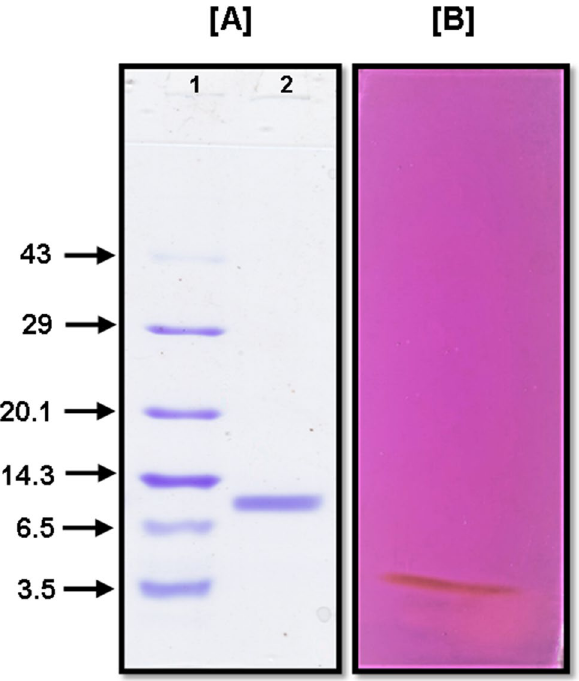
Figure 1. ( A ) SDS-PAGE profile (15%), analyses of purified SSTI from, S. surattense seeds, stained with Coomassie Brilliant Blue. (1) Standard protein markers, (2) purified fraction after cation exchange resin; ( B ) PAS staining of purified SSTI, indicating its glycoprotein nature (12% SDS-PAGE). Uncropped gel images are shown in Supplementary Figure S2A and B.